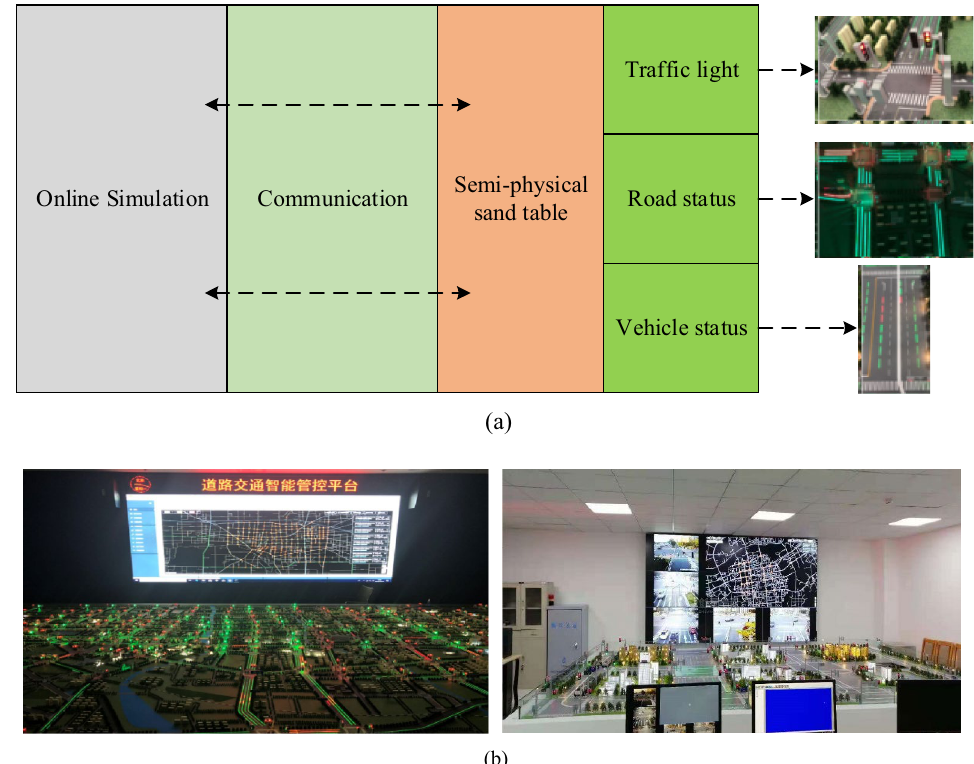
Figure 5. "Online-HILS" parallel simulation. ( a ) "Online-HILS" parallel simulation structure. ( b ) "Online- HILS" parallel simulation display.